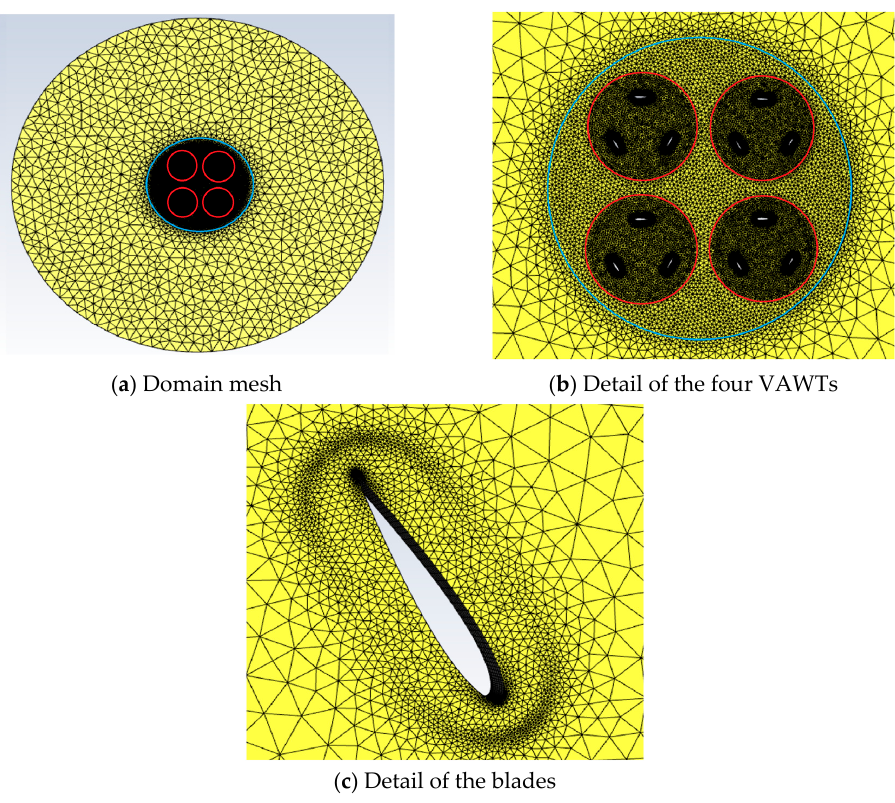
Figure 2. Mesh for group of four VAWTs in close proximity (or farm): ( a ) Domain mesh, ( b ) Mesh for four VAWTs in close proximity and ( c ) Detail of the